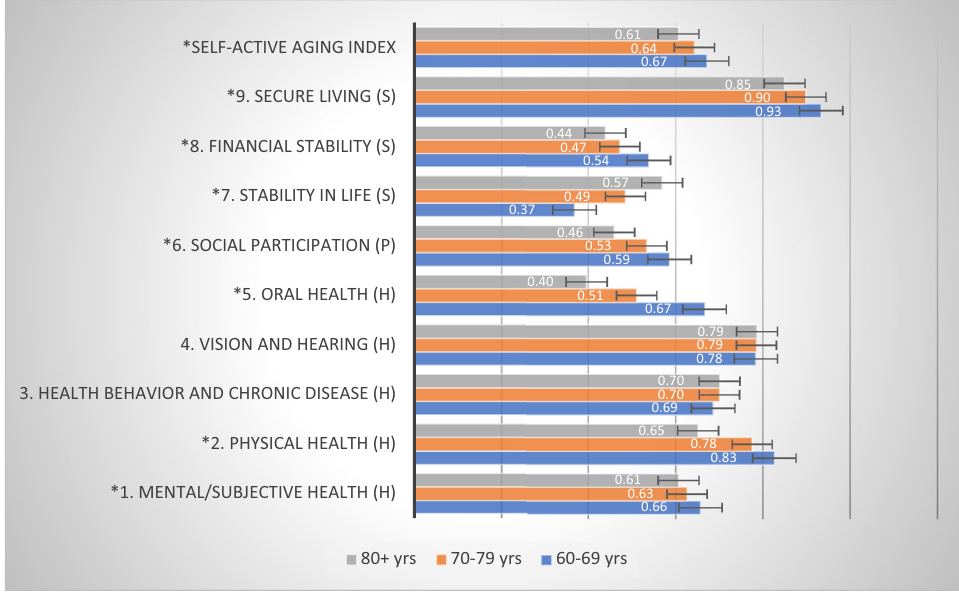
Figure 3. S-AAI scores classified by age